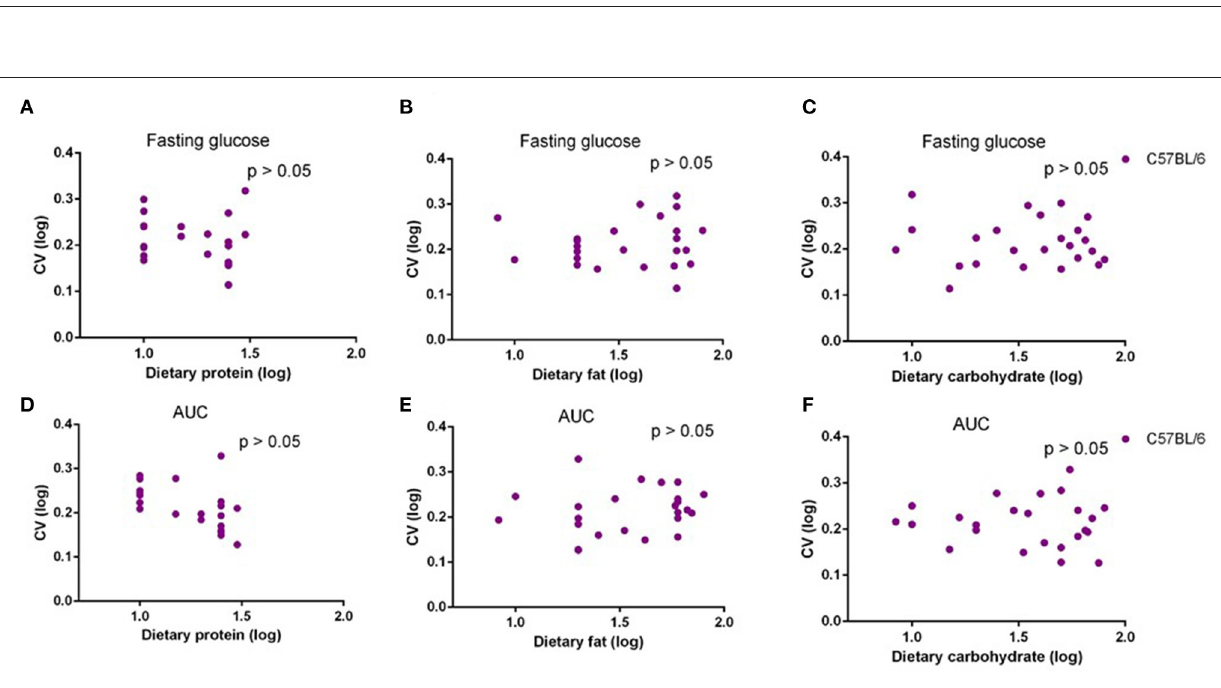
Frontiers in Nutrition |